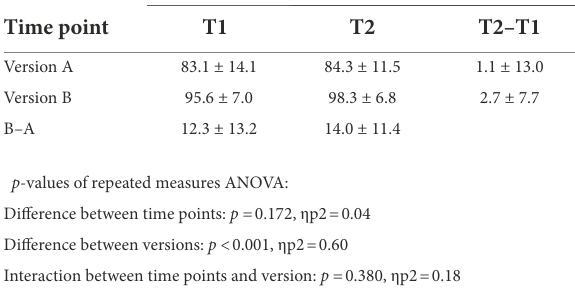
TABLE 3 Effect of wording and timing of risk information to obtain informed consent on maximal arm muscle strength.